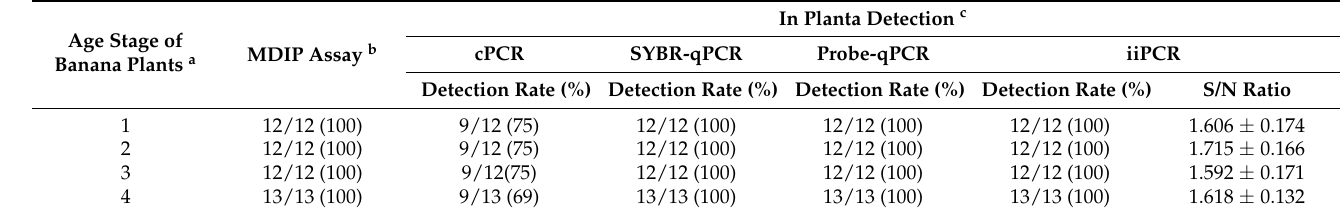
Table 8. Comparison of Fo iiPCR and molecular detection methods for field detection of Fusarium oxysporum infection of different age stages of banana plants with mild symptoms using a rapid DNA extraction protocol.